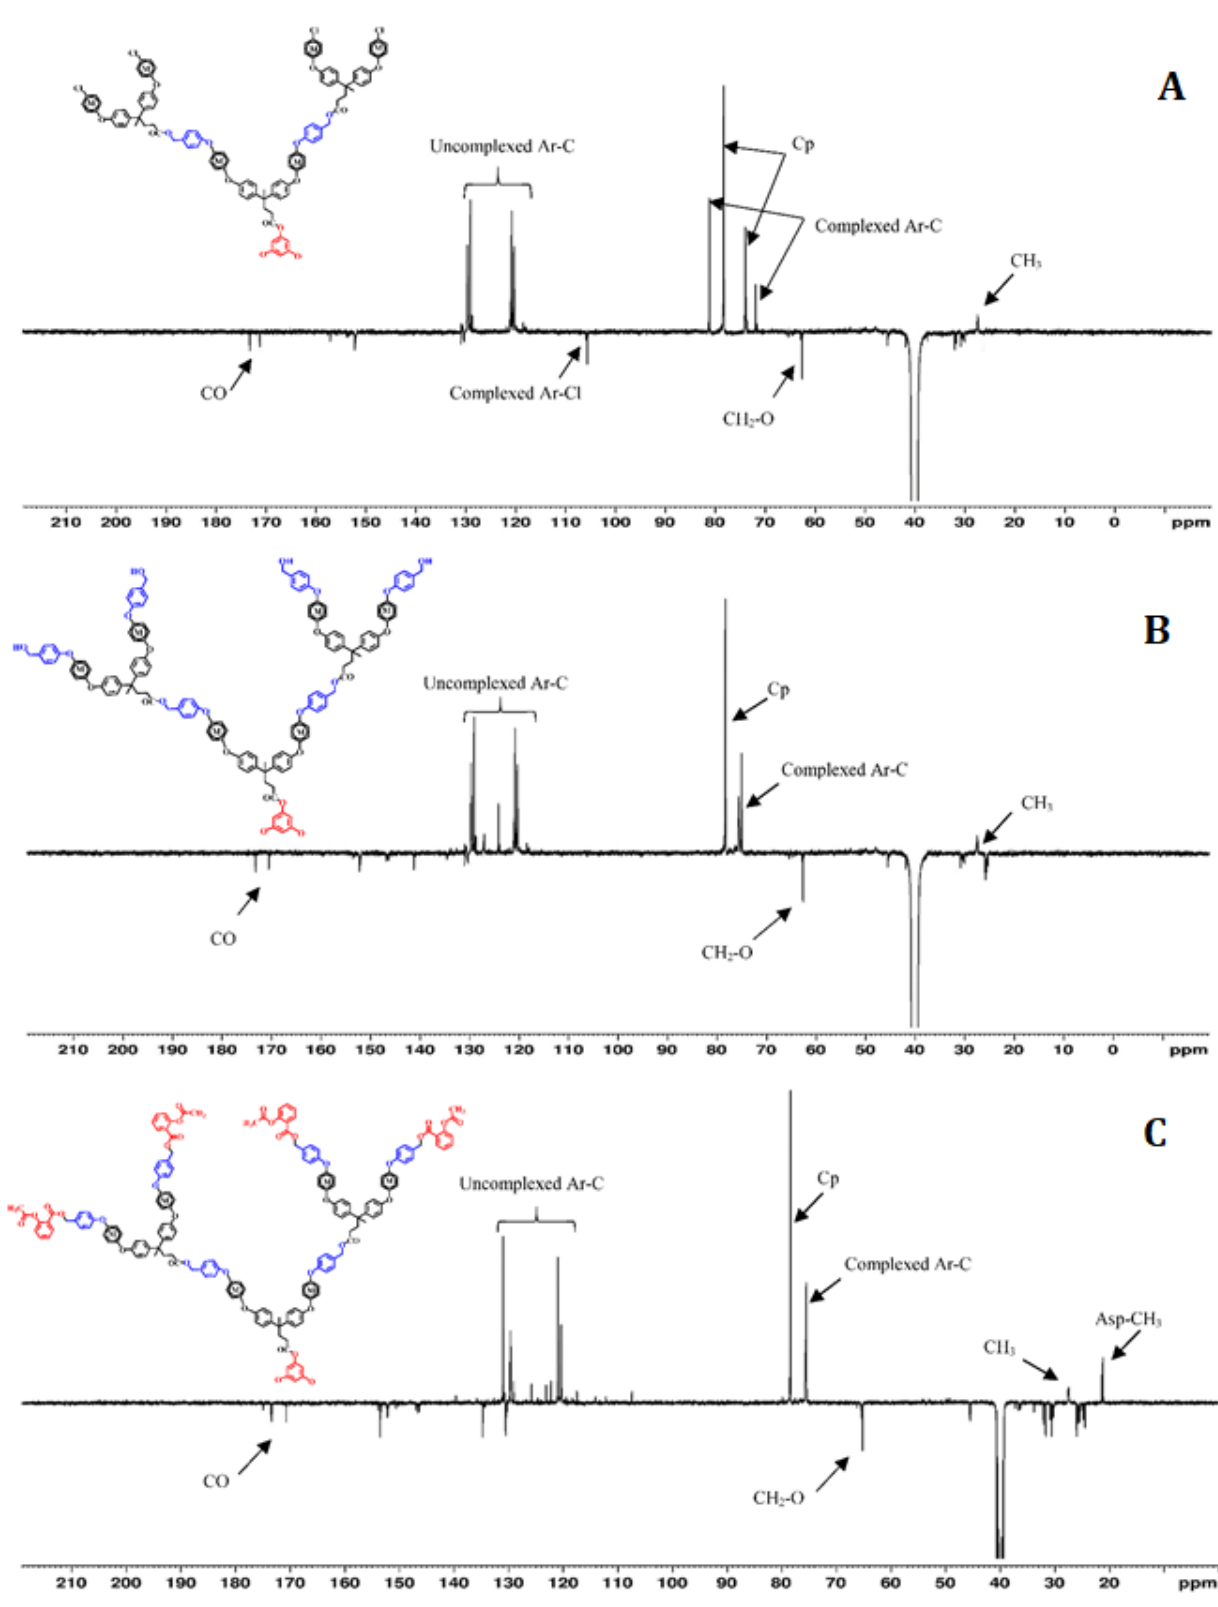
Figure 2. 13 C-NMR spectra of ( A ) G2-D4 , ( B ) G2-D5 , and ( C ) G2-D6-Asp in DMSO-d 6 .